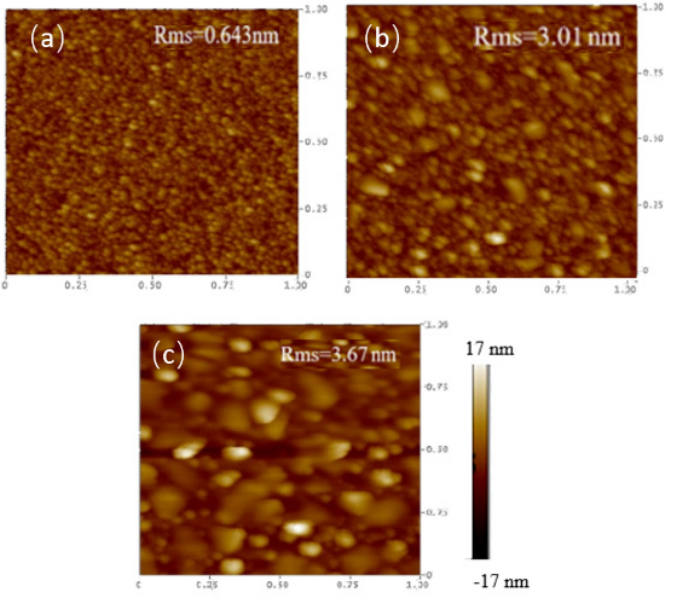
Figure 3. AFM images for ( a ) IGZO sample ( b ) IGZO with NH 3 plasma treatment ( c ) Mg doped IGZO with NH 3 plasma treatment.